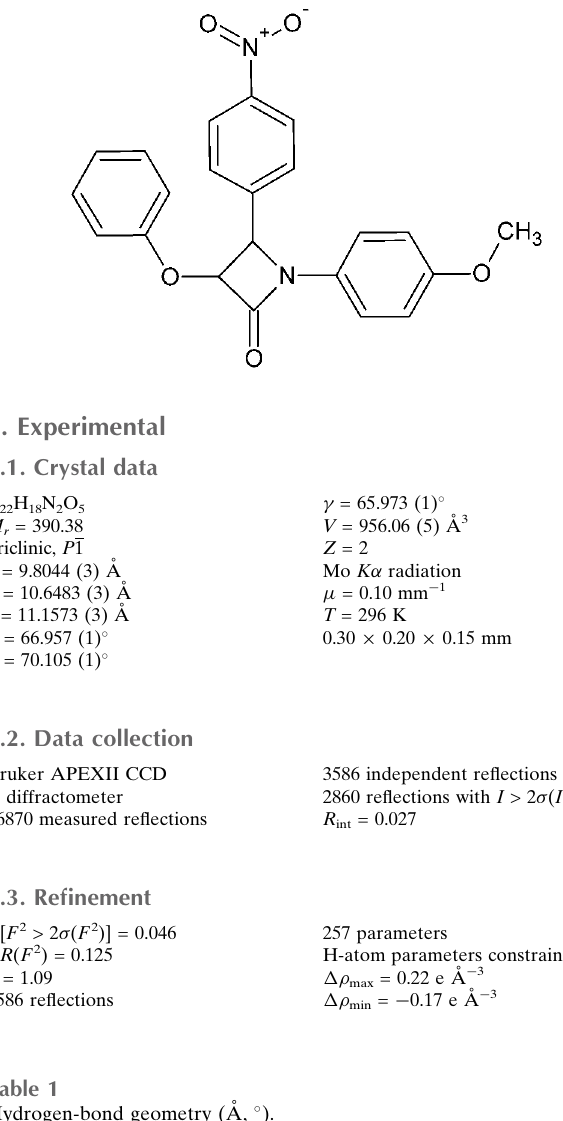
Hydrogen-bond geometry (A˚ , (cid:2)